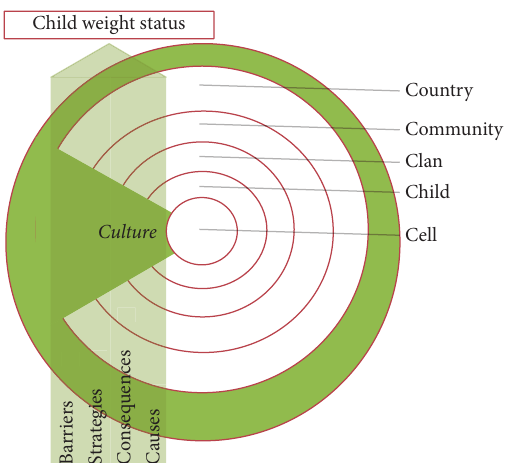
Figure 2: Six C’s of childhood obesity perceptions among child- minders and health workers in South